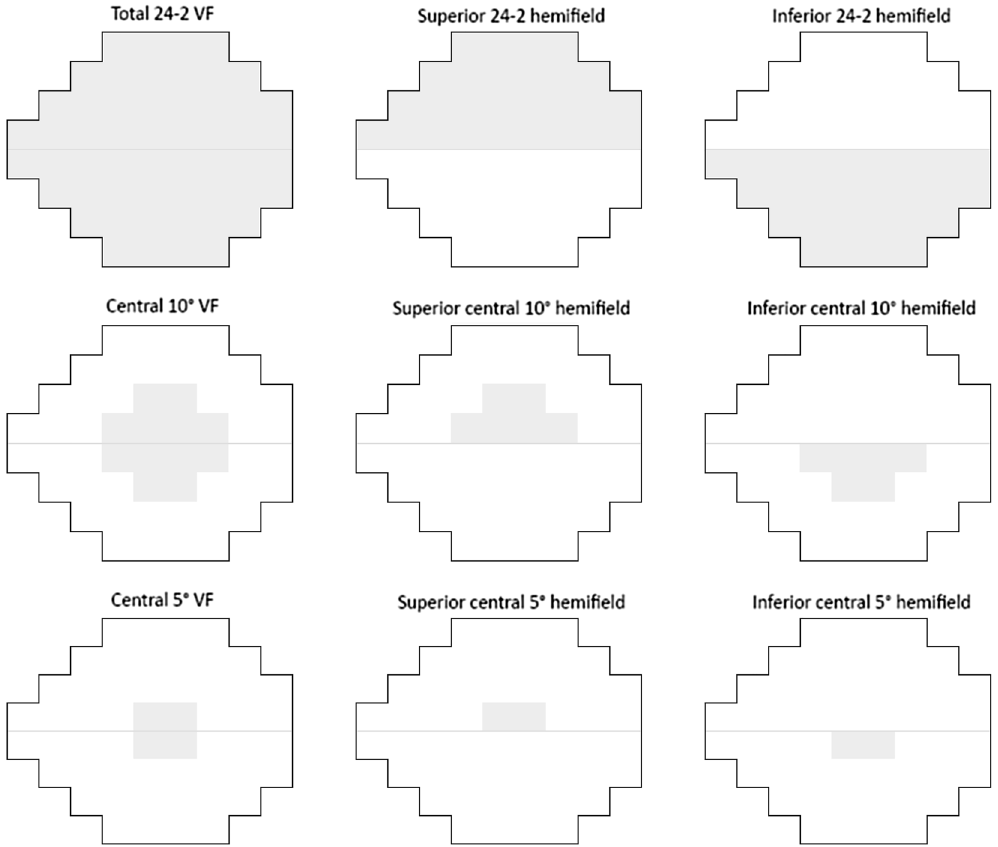
Figure 2. The 24-2 visual field sectors defined to estimate the correlations with contrast sensitivity. VF = visual